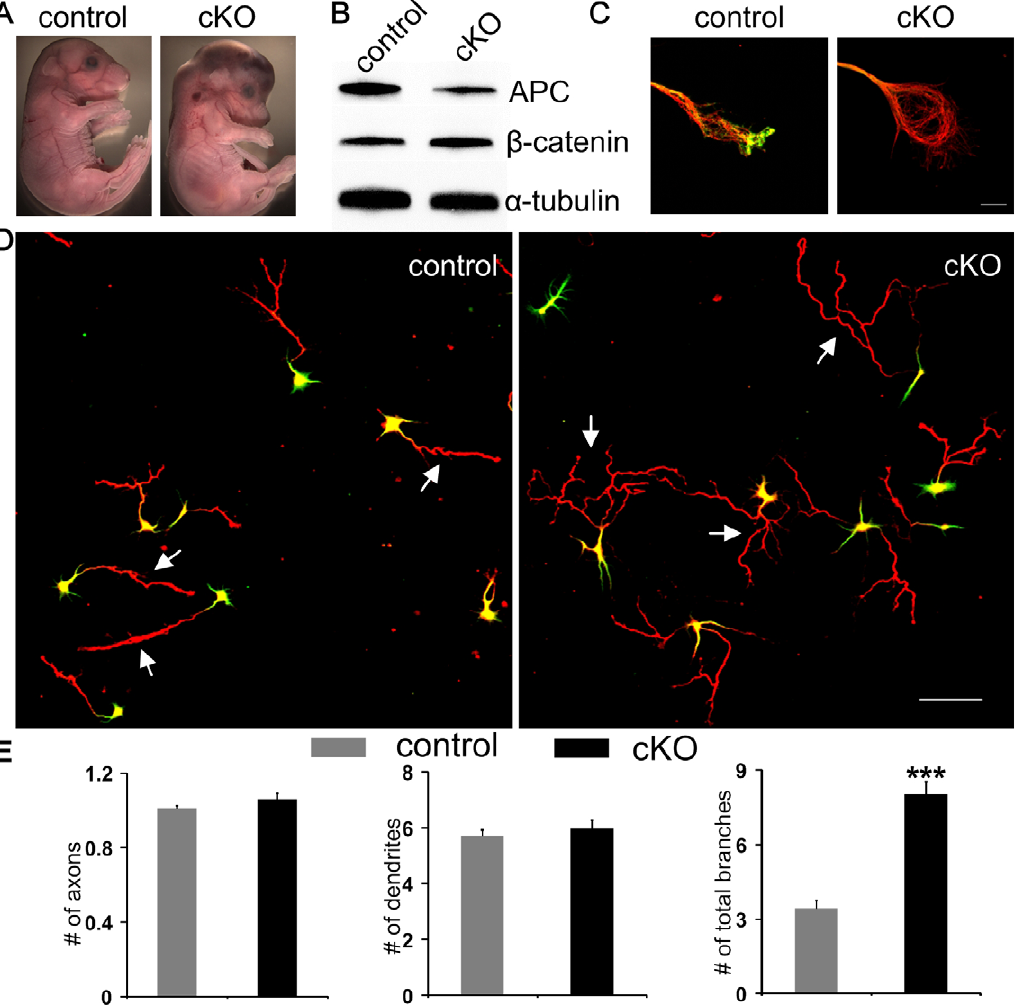
Figure 1. Deletion of APC induces excessive axon branching. (A) Control (left) and APC-cKO mouse embryos (right) at E16.5. (B) Western blot of dissociated control and APC cKO cortical cultures. Residual APC is likely due to non-neural cells in the culture derived from cells that did not undergo recombination. b -catenin protein levels were increased as expected. a -tubulin was used as a loading control. (C) Immunostaining showing APC accumulation at the growth cone tip in control axons (left) and absence of APC in APC-deficient axons (right). (D) Control and APC deficient cortical neurons cultured for four days and double labeled with antibodies against axon marker Tau1 (red) and dendritic marker MAP2 (green). Note that most APC-deleted neurons have highly branched axons (arrows). (E) Average numbers of axons, dendrites, and total axonal branches per neuron. Values are means 6 SEM. ***: P , 0.001 by student t test. More than 5 independent experiments were performed. Scale bars: C 5 m m, D 100 m m.